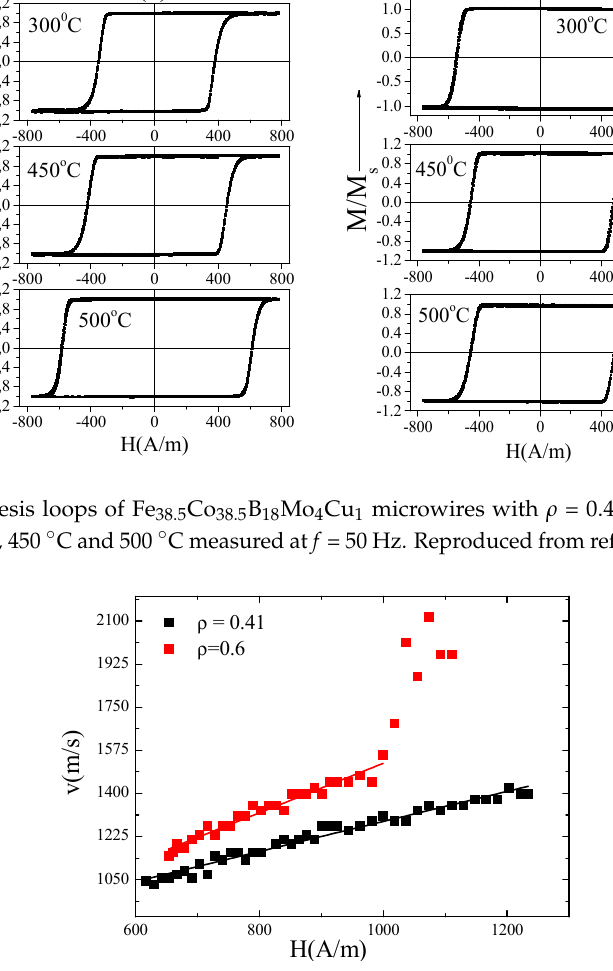
Figure 14. Domain wall (DW) velocities as a function of magnetic field for as-cast Hitperm Fe 38.5 Co 38.5 B 18 Mo 4 Cu 1 microwires with ρ = 0.41 and ρ = 0.6. Reproduced from reference [70], Figure 7. The non-linear v(H) dependencies observed in both samples (Figures 14 and 15) can be ascribed either to multiple DW nucleation at defects and/or the change of the domain structure from transversal to vortex-type.